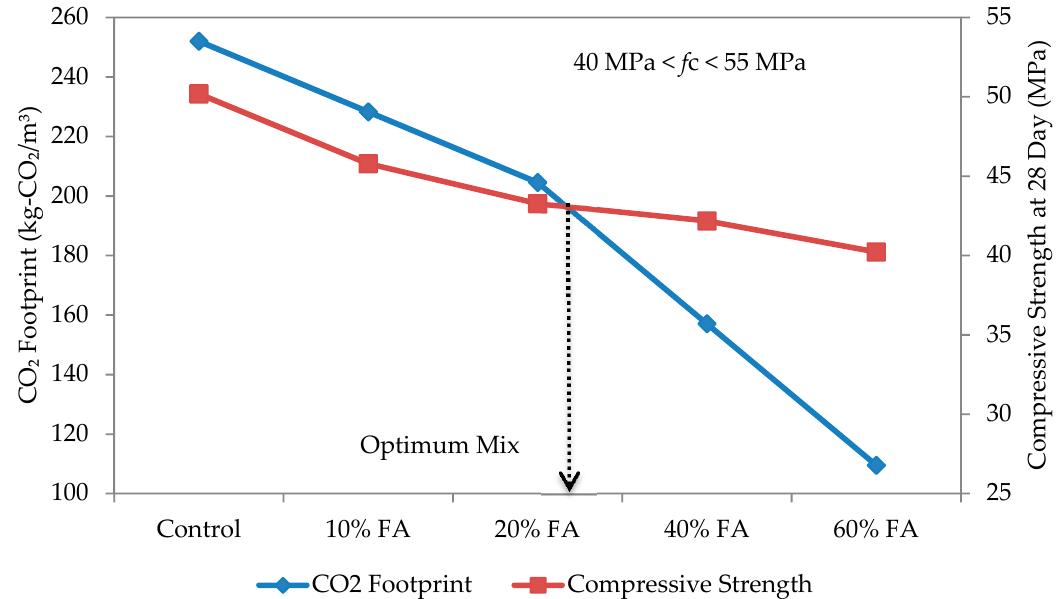
Figure 16. Optimum mix for self-compacting mortar at w/b 0.45.